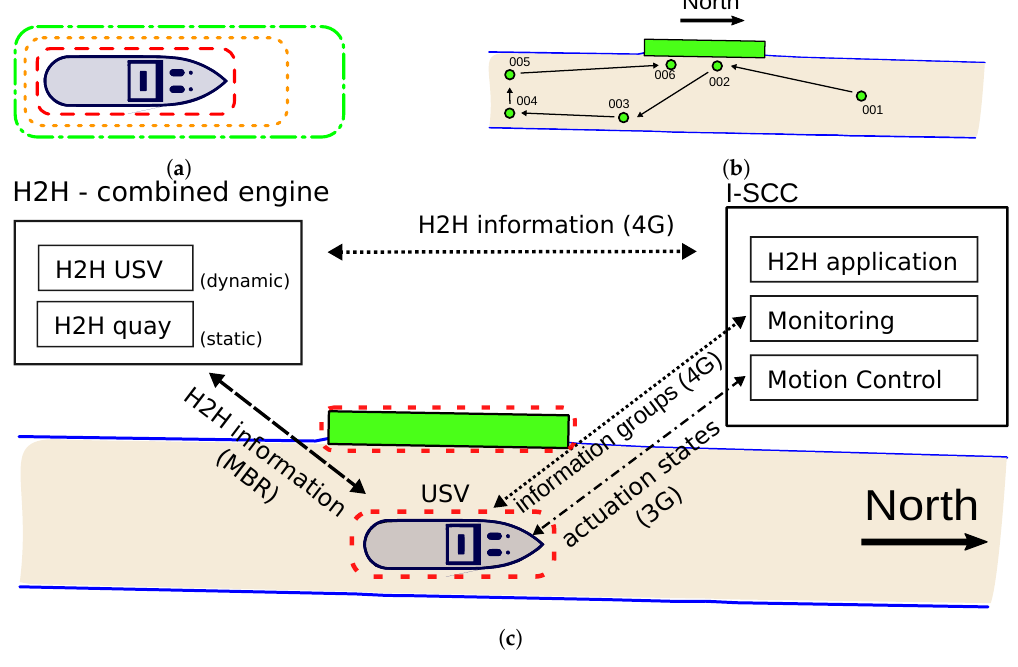
Figure 6. Augmented remote motion control and monitoring within the H2H project: ( a ) proximity zones, ( b ) envisaged design docking manoeuvre experiments, and ( c ) design philosophy of the H2H-extensions on the I-SCC